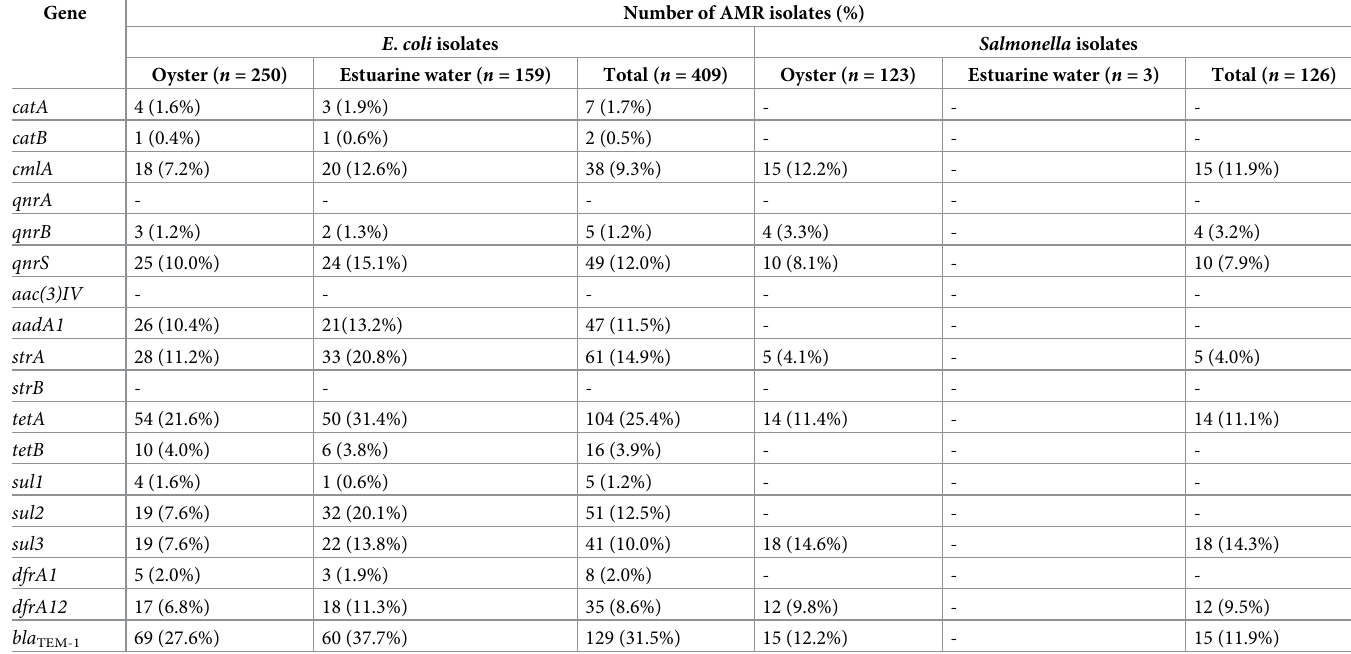
Table 5. Genotypic characterization of E . coli ( n = 409) and Salmonella ( n = 126) isolated from oysters and estuarine waters.